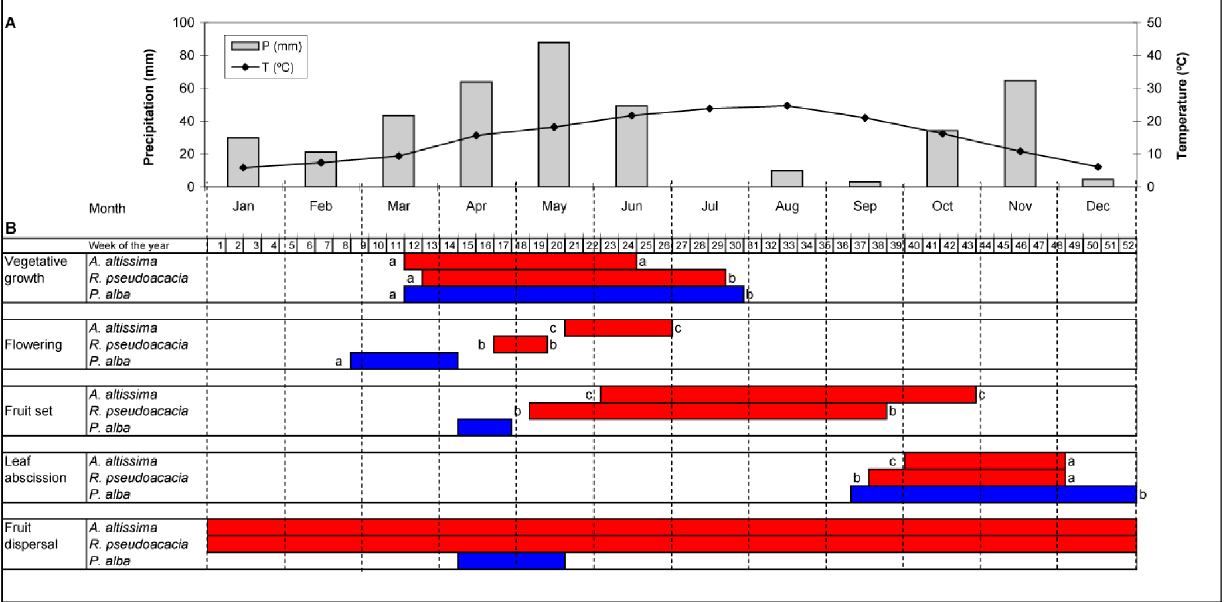
Figure 1. Climatic conditions and plant phenology. A) Climatic diagram showing monthly mean temperature and precipitation during 2011 (Torrejo´n de Ardoz weather station). B) Diagrams of phenological activity of the three species in 2011. Different letters across species for the beginning or end of each phenophase indicate significant differences after a pairwise Watson-Williams multisample test ( P , 0.05). Missing letters means that comparisons could not be performed for all species due the lack of variation between